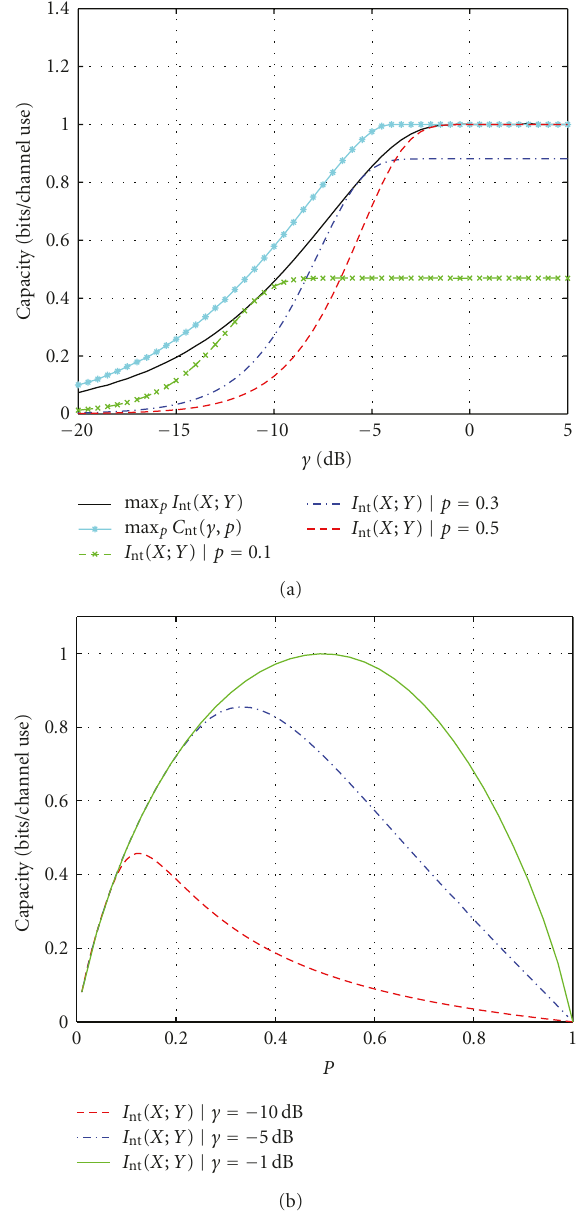
Figure 2: (a) Maximization of the capacity bound in (15) and mutual information over the input distribution p for the nonturbulent optical channel when κ = 20 and a rectangular pulse shape with ξ = 1 are adopted. (b) Mutual information versus the input distribution p for values of SNR of γ = − 1dB, γ = − 5 dB, and γ = − 10